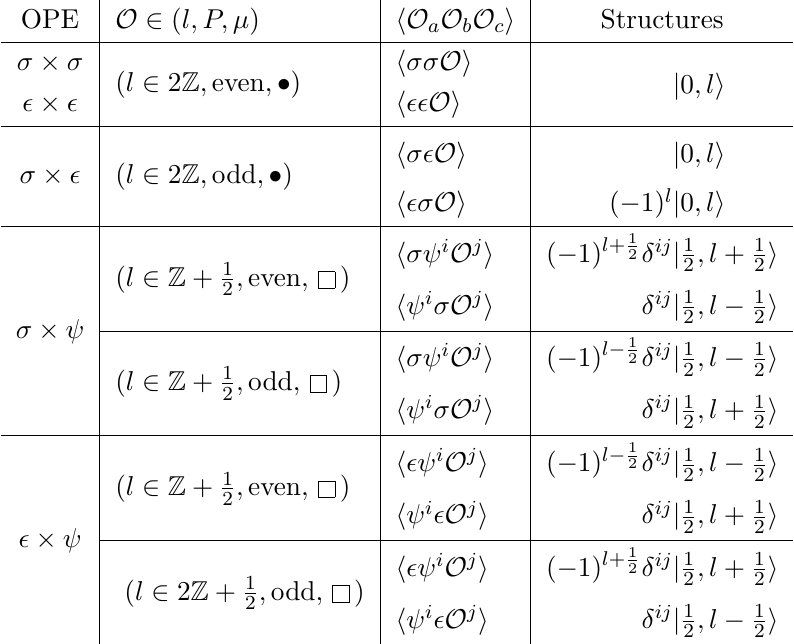
Table 3 . Tensor structures appearing in the OPEs of mixed scalar-fermion operators. OPE O ∈ ( l, P, µ )